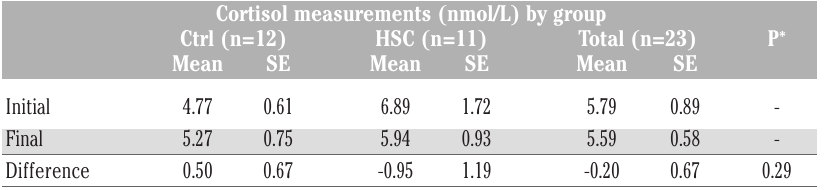
Table 2. Outcome